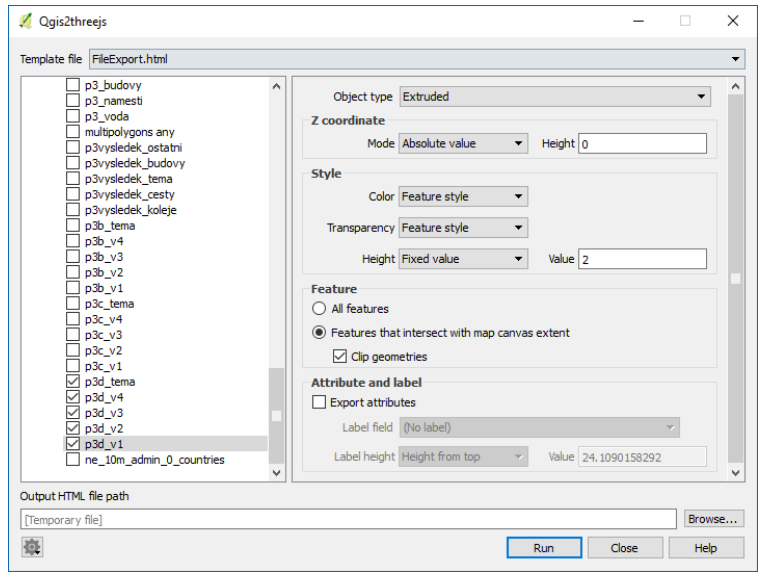
Figure 8. Interface of the Qgis2threejs plugin where individual layers are being chosen in the left menu, and the bottom (Z coordinate/Height) and top (Style/Height) levels are set for extrusion.